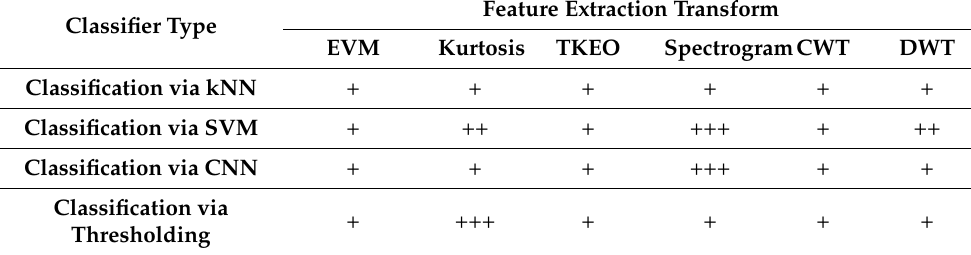
Table 3. Preliminary analysis on the suitability of various feature-extraction transforms for vari- ous classification methods (+ = low , ++ = medium, +++ = high) in the context of pre-correlation GNSS data.